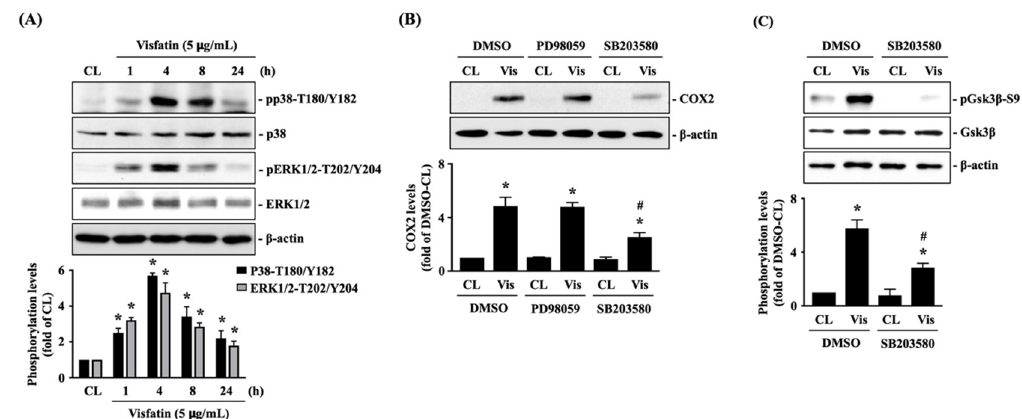
Figure 2. p38 signaling regulates the effect of visfatin on GSK3 β inactivation and subsequent COX2 expression in human primary chondrocytes. ( A ) Human primary chondrocytes were kept as controls (CL) or treated with 5 µ g/mL of visfatin for 1, 4, 8 and 24 h, and then the p38 ‐ Thr180/Tyr182 and ERK1/2 ‐ Thr202/Tyr204 kinases phosphorylations were analyzed by Western blot. ( B – C ) Human primary chondrocytes were pretreated with DMSO, PD98059 (ERK1/2 inhibitor, 30 μ M), or SB203580 (p38 inhibitor, 10 μ M) for 1 h and then kept as controls (CL) or treated with 5 μ g/mL of visfatin (Vis) for 8 h. COX2 expression ( B ) and GSK3 β‐ Ser ‐ 9 phosphorylation ( C ) in human primary chondrocytes were analyzed by Western blot. Results in ( A – C ) are representative of three independent experiments with similar results. Statistic data in ( A – C ) are mean ± SEM from three independent experiments. *, p < 0.05 vs. untreated control cells (CL) or DMSO-CL-treated cells. #, p < 0.05 vs. DMSO-visfatin (Vis)-stimulated